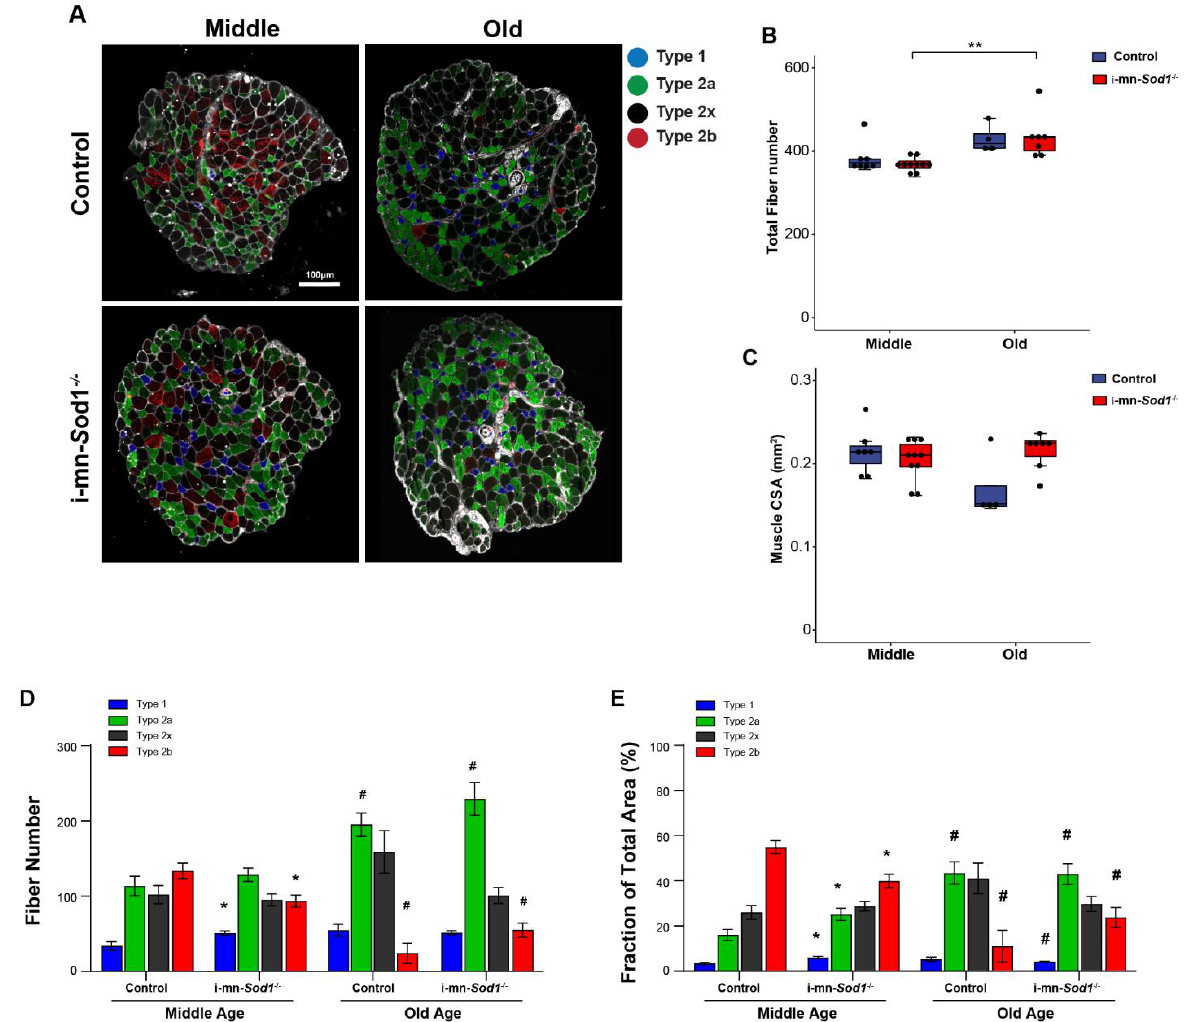
Figure 7. Fiber type composition in lumbrical muscle between control and i -mn- Sod1 -/- mice. ( A ) Representative immunofluorescence images of lumbrical muscle cross sections for control and i-mn- Sod1 -/- mice at middle- and old-age. Fiber types are represented in different pseudo-color as type 1 (blue), type 2a (green), type 2x (black), type 2b (red). Scale bar (100µm) is labeled in image. Data are shown for ( B ) total fiber number and ( C ) total lumbrical muscle cross-sectional area for muscles of controls (blue; n = 7 for middle age, n = 4 for old age) and i -mn- Sod1 -/- mice (red; n = 10 for middle age, n = 7 for old age) and are presented as individual data points with box plots and error bars indicating the minimum, first quartile, median, third quartile, and maximum number of the dataset. These data were analyzed by two-way ANOVA, ** p < 0.01. Additionally, shown are ( D ) the number of each type of fiber and ( E ) the fraction of the total muscle cross-sectional area occupied by each type of fiber in lumbrical muscles from control and i -mn- Sod1 -/- mice at middle and old-age. Data are presented as means+SEM and analyzed by two- way ANOVA, Turkey’s multiple comparisons test. * p < 0.05 compared to control littermates and # p < 0.05 compared to same genotype mice at middle-age. Sample sizes for control mice are n = 7 for middle age and n = 4 for old age and n = 10 for middle age and n = 7 for old age for i -mn- Sod1 -/- mice.